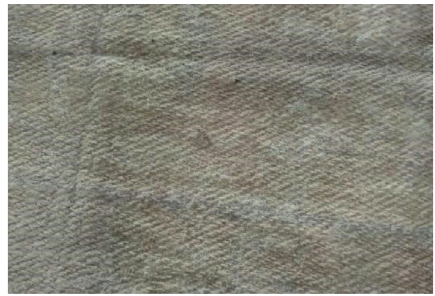
Figure 1: Used jute fiber